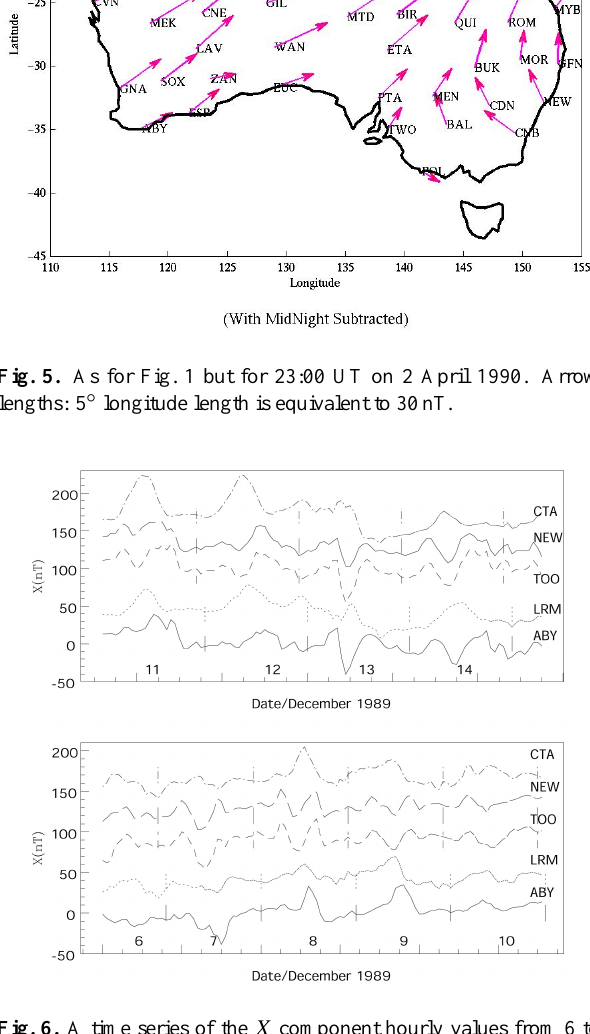
Fig. 6. A time series of the X component hourly values from 6 to 14 December 1989. CTA (Charters Towers), NEW (Newcastle) and TOO (Toolangi) are in the east while LRM (Learmonth) and ABY (Albany) are in the